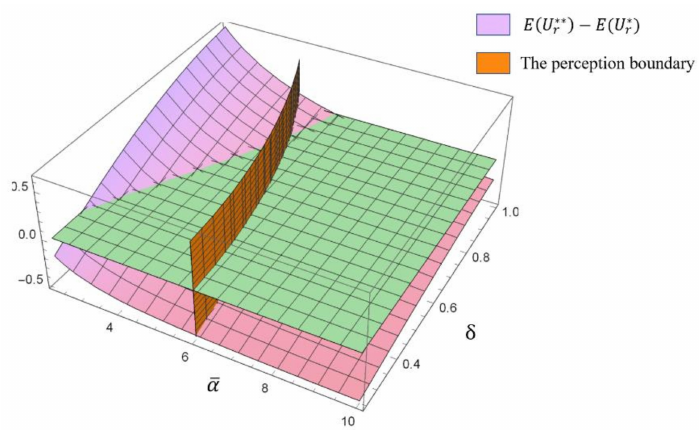
Figure 7. The e ff ects of the highest fixed payment α and the unit subsidy δ on the di ff erence between the remanufacturer’s utilities E ( U ∗∗ r ) − E ( U ∗ r )